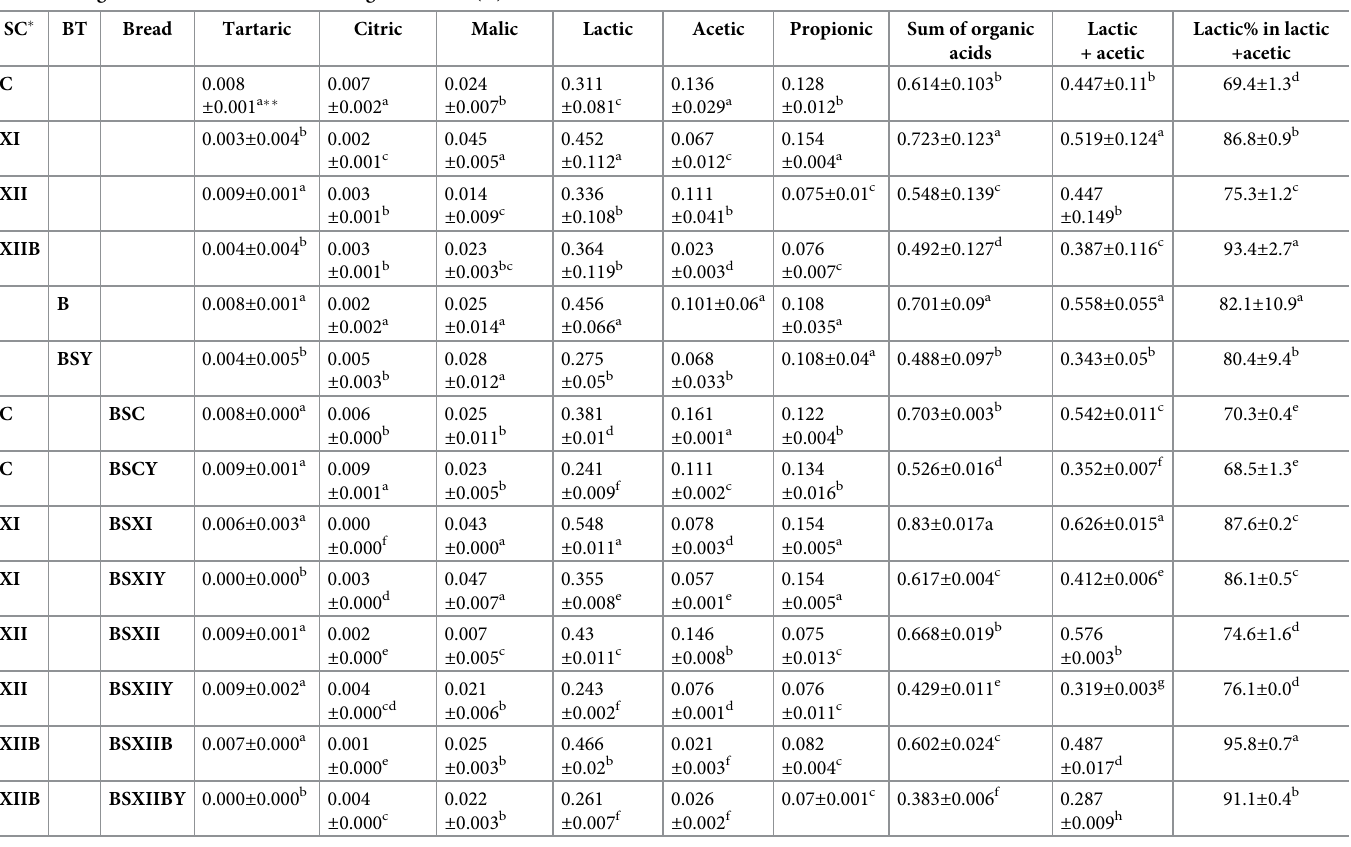
Table 4. Organic acids content in the investigated breads